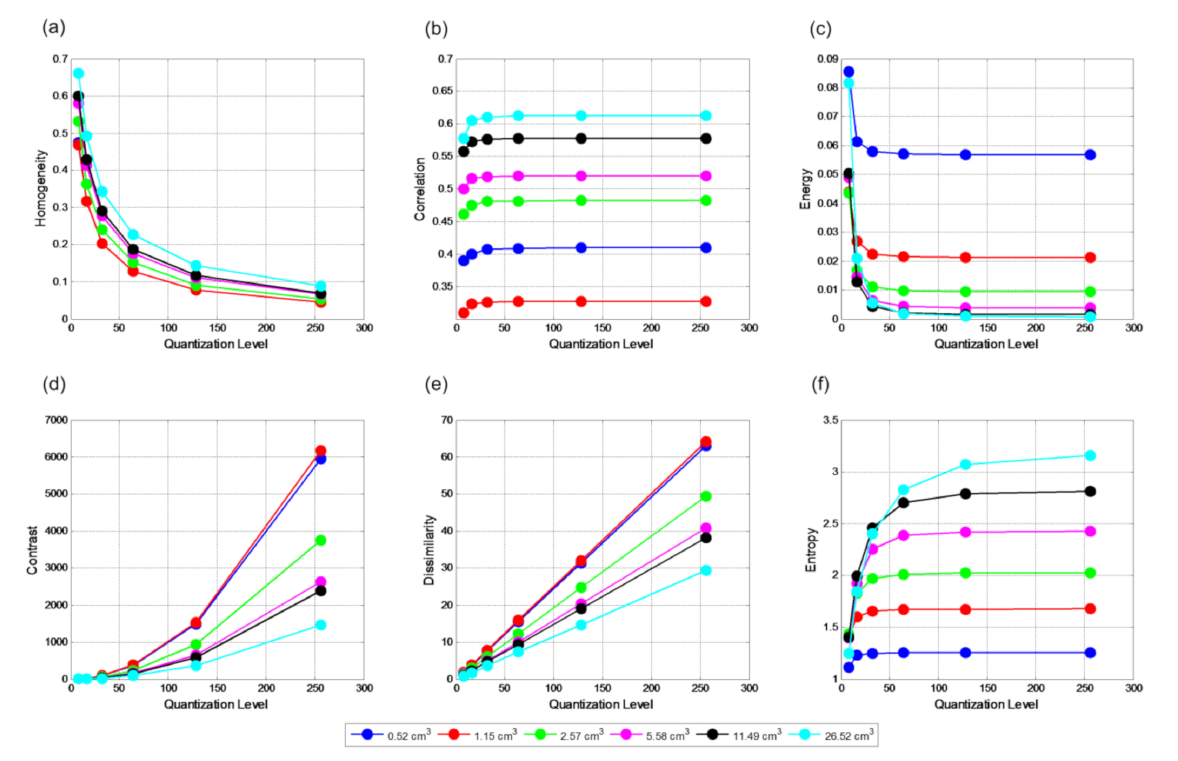
Figure 3. Mean six textural features of five realizations against quantization for VOI true for all six spheres. ( a ) Homogeneity, ( b ) contrast, ( c ) energy, ( d ) contrast, ( e ) dissimilarity and ( f ) entropy. The features shown here are for 4:1 contrast and 900 s acquisition